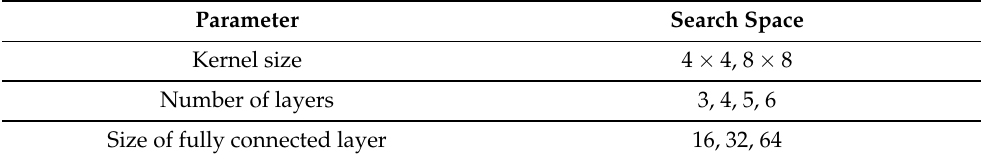
Table 2. Network configurations involved in model